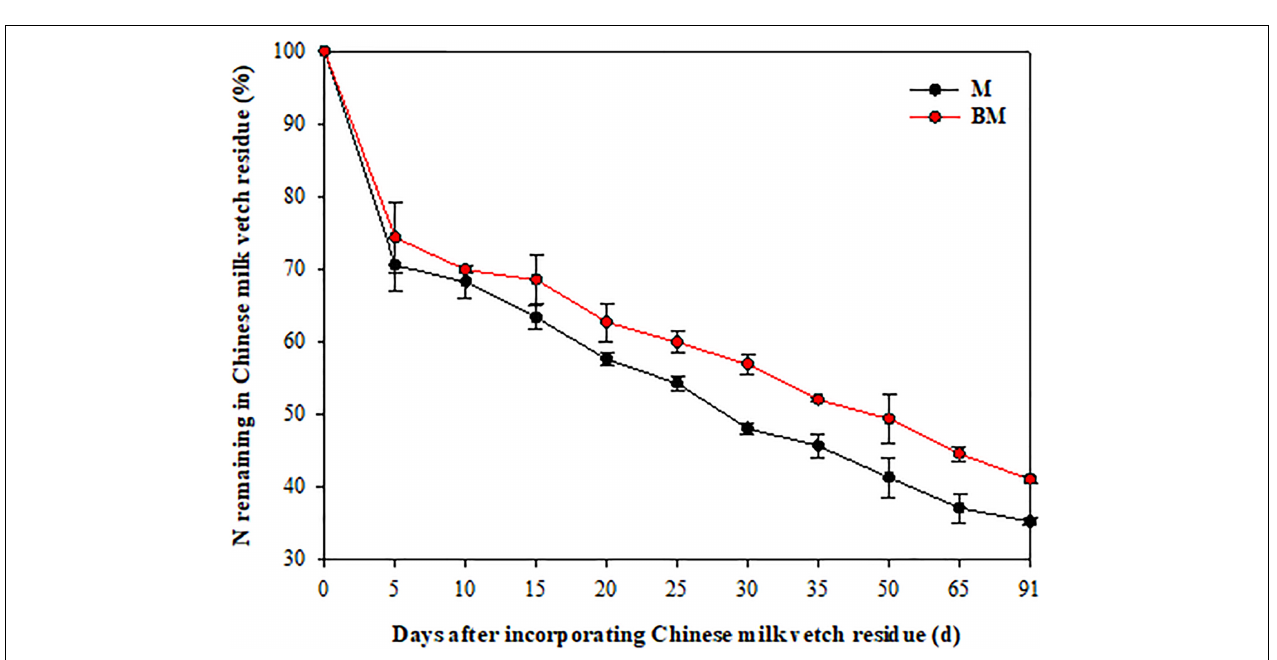
FIGURE 1 | Dry matter decay pattern of leguminous crop after incorporation to reddish paddy soil. Small bars are standard errors.